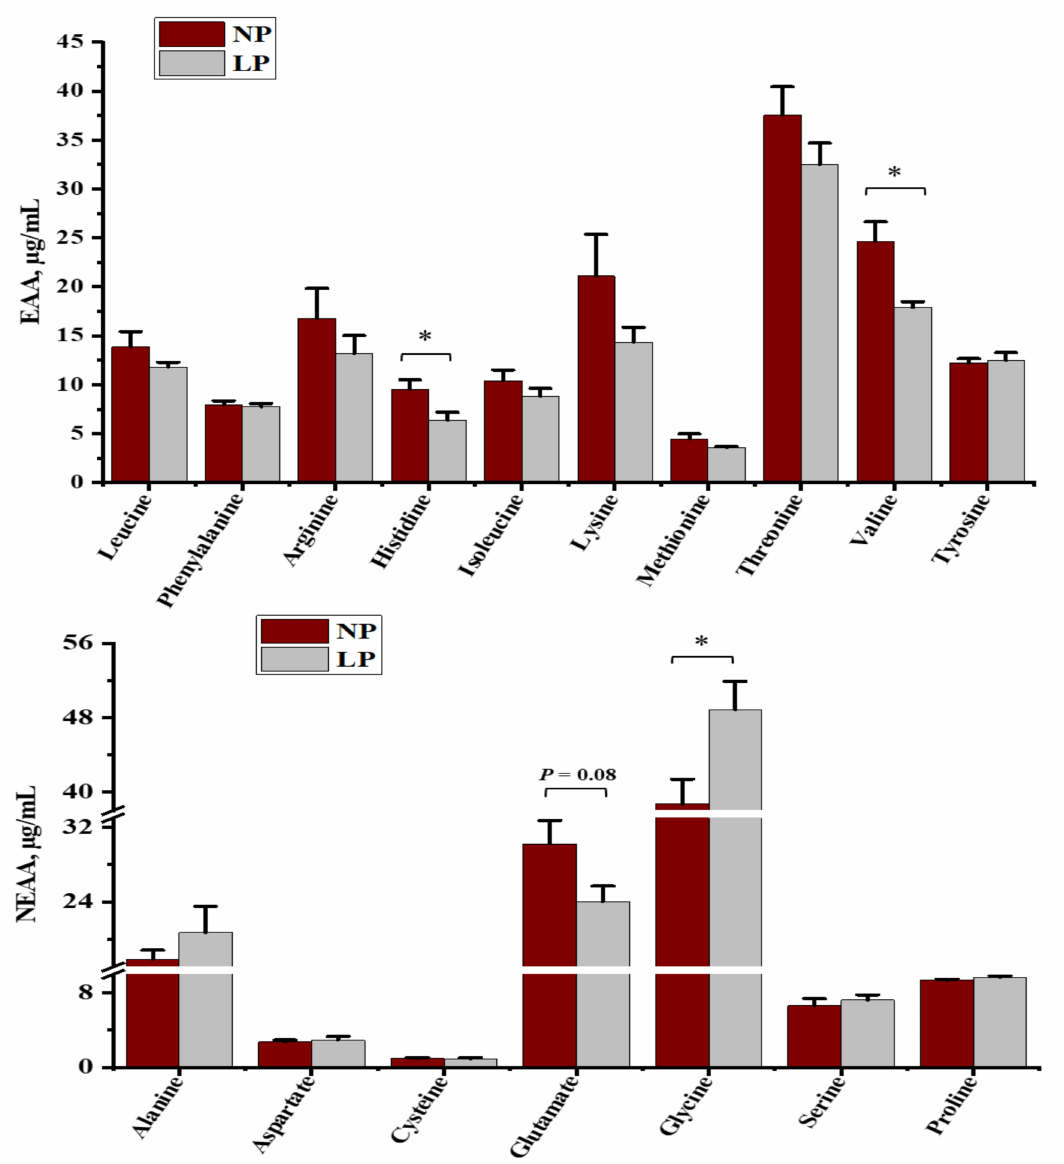
Figure 4. Plasma free amino acid concentrations in goats fed a low-protein diet. The results are presented as the mean ± SE; * = p < 0.05. NP = a control protein diet; LP = a low-protein